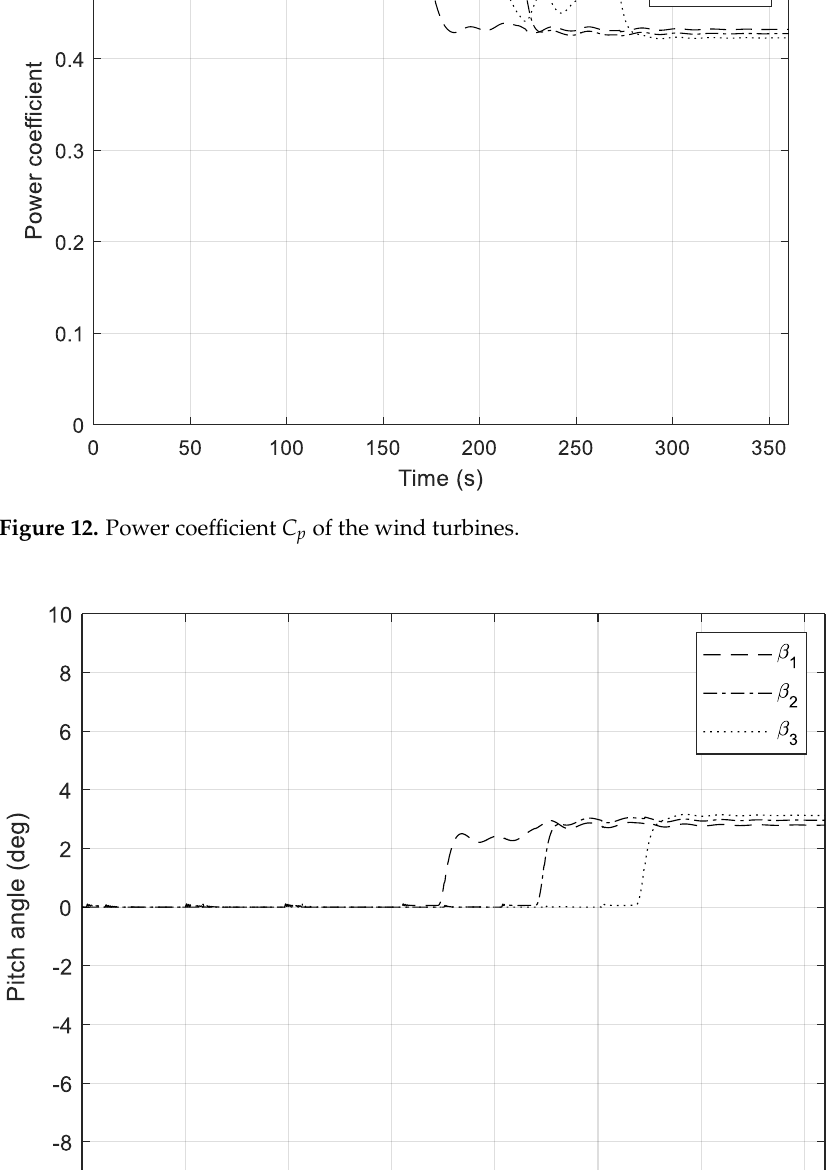
Figure 13. Pitch angles of the wind turbines.